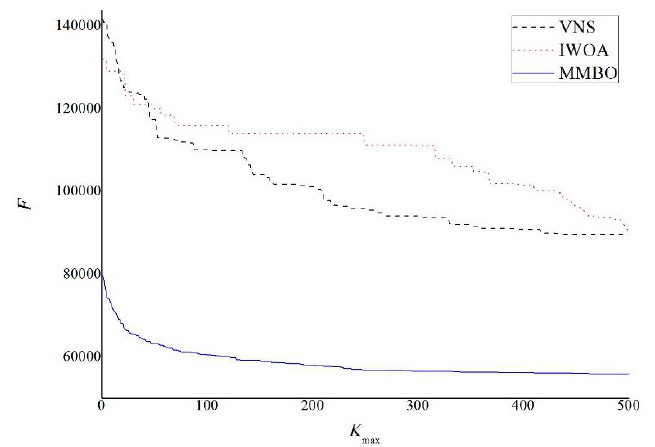
Figure 3. Convergence curve of the compared algorithms in Instance RM09.